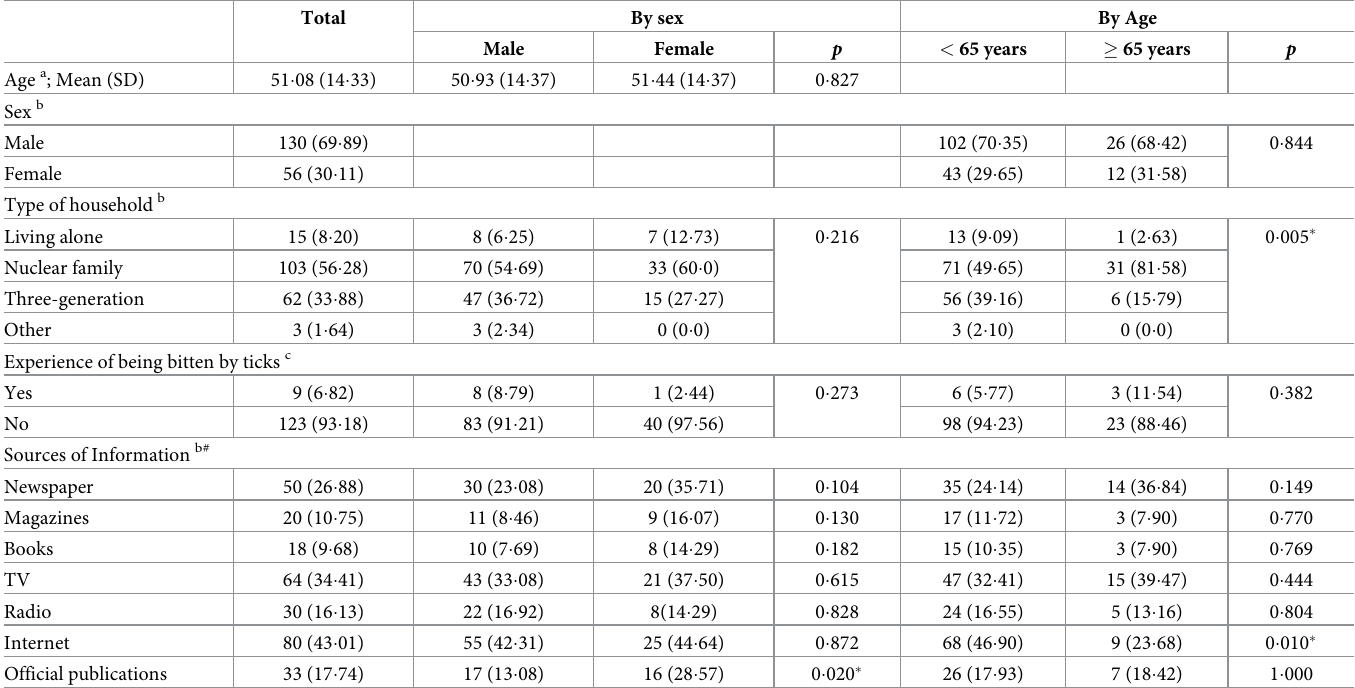
Table 1. Basic characteristics of respondents with comparison by age and